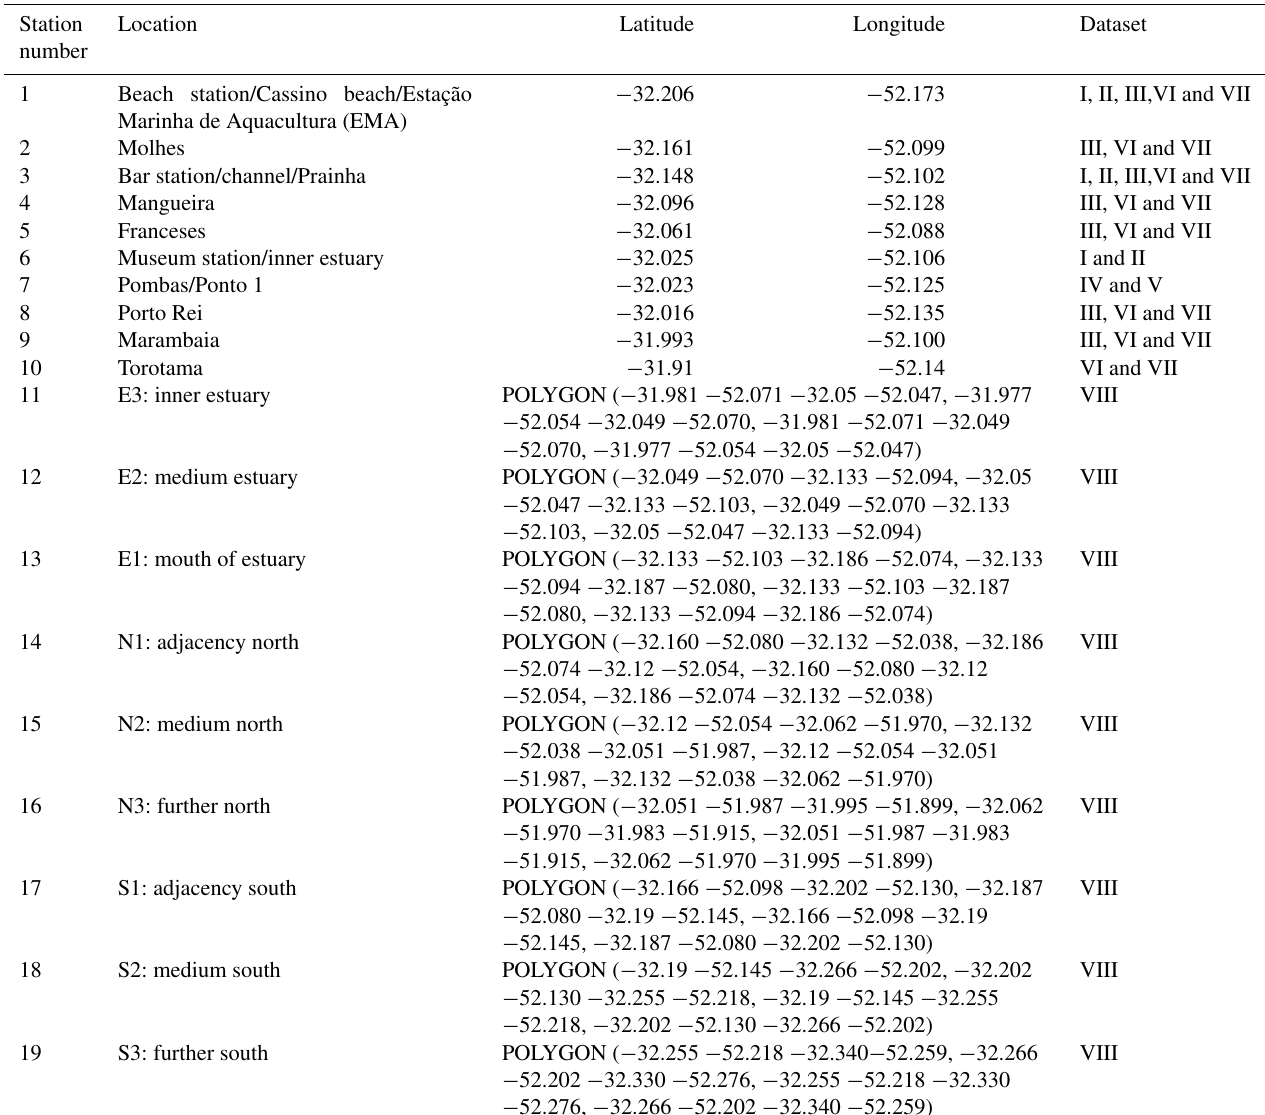
Table 1. Geographic locations at sampling stations of the Brazilian Long-Term Ecological Research program in the Patos Lagoon estuary and adjacent marine coast,